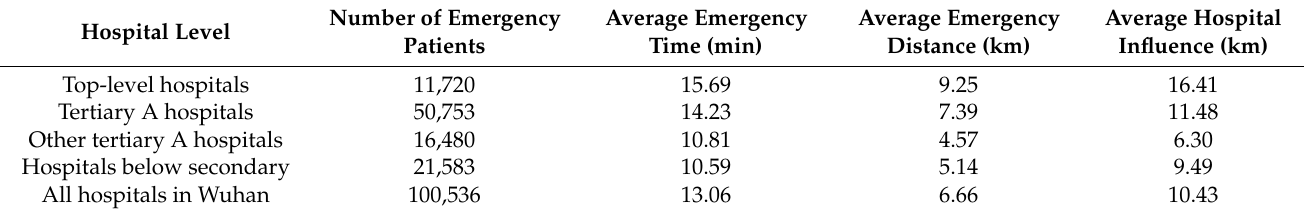
Table 1. Emergency indicators obtained for hospitals of different